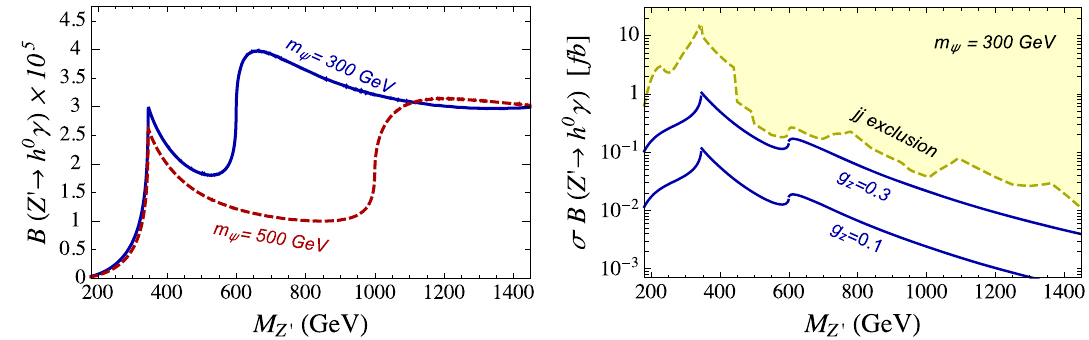
Fig. 4 Left panel The Z (cid:2) → h 0 γ branching fraction for flavor- universal vector couplings of Z (cid:2) to the SM quarks with z F = 1 / 3, when two vectorlike leptons with z ψ = − 1 are running in the loop. The mass of lightest vectorlike lepton is m ψ = 300 GeV (blue solid line) or 500 GeV (dashed red line); the mixing angle and the Higgs